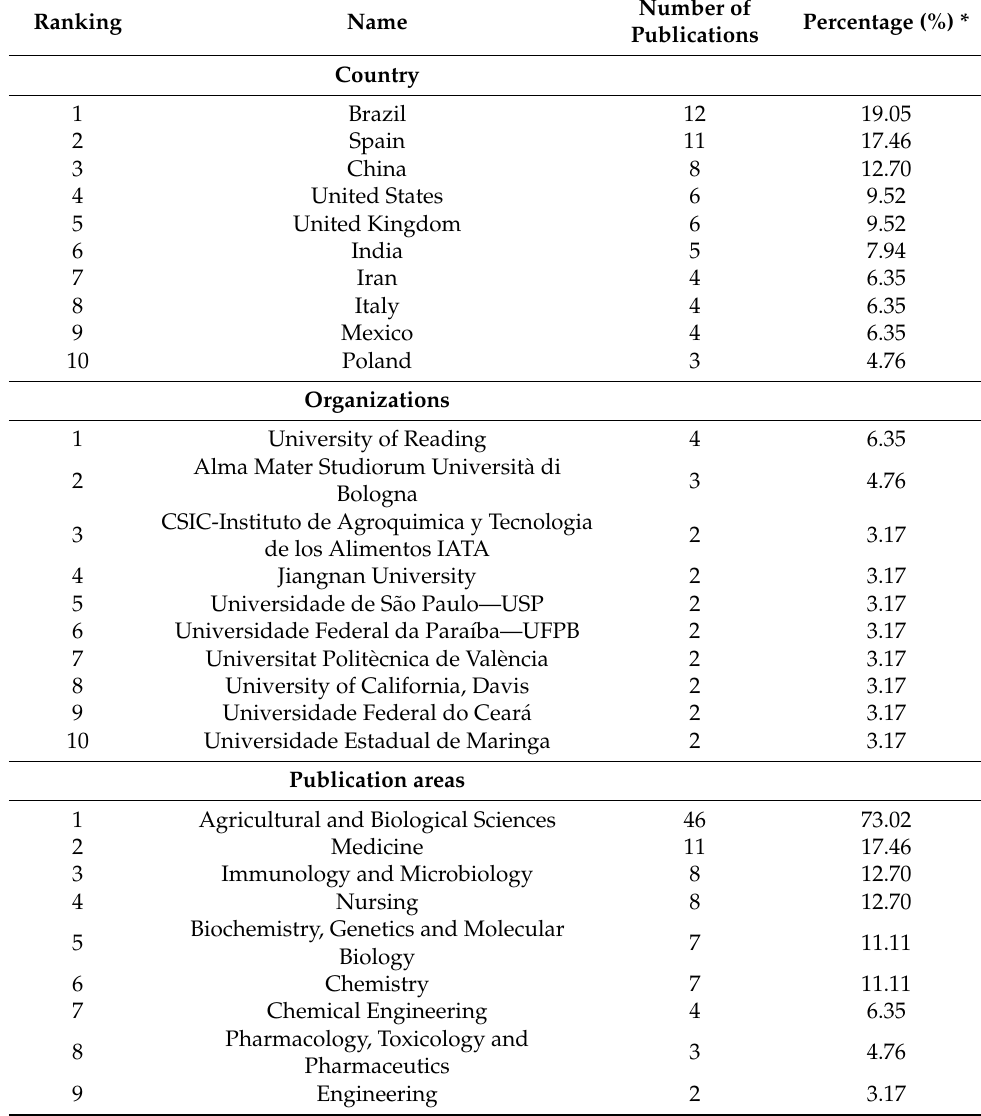
Table 1. Rankling of the main contributors to the scientific production of probiotics in citrus fruits about the number of publications by country, institutional affiliation, and publication